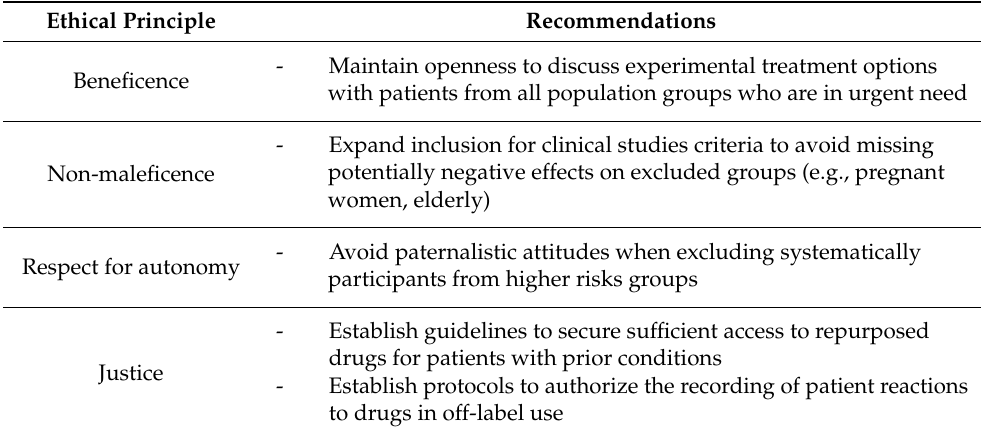
Table 2. Recommendations based on the experience during the early